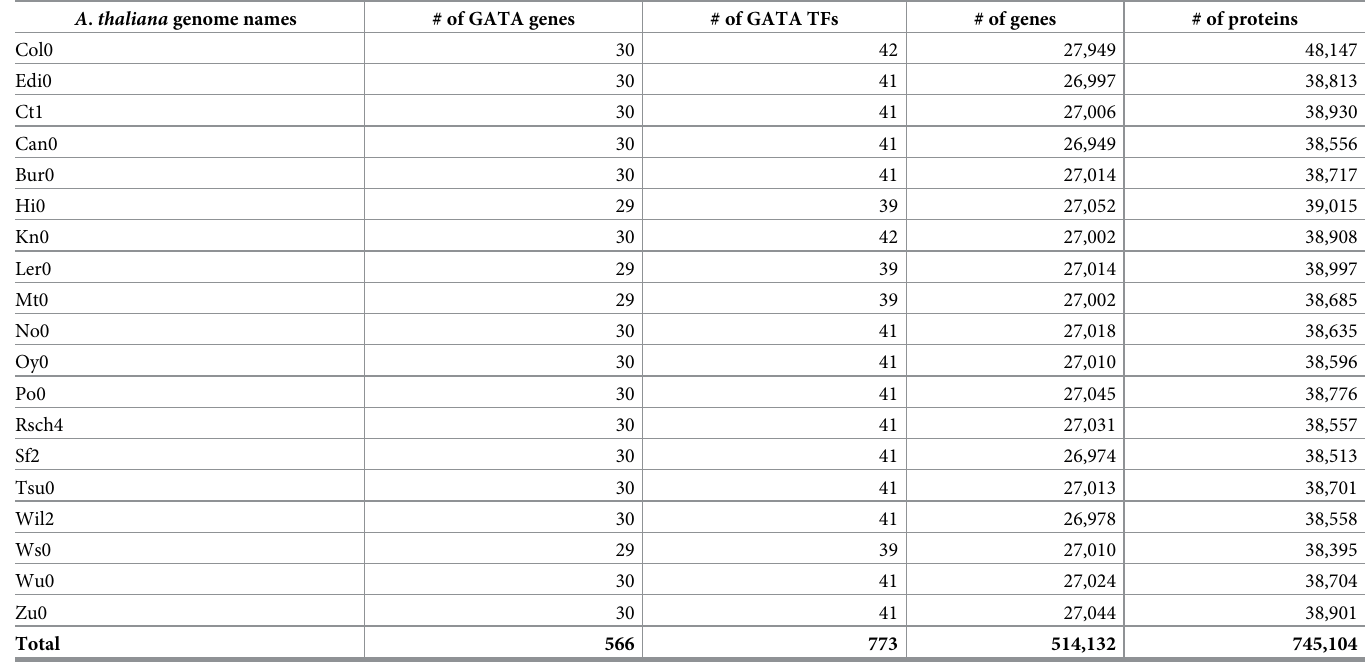
Table 1. Summary of identified GATA TFs from 19 A . thaliana genomes.